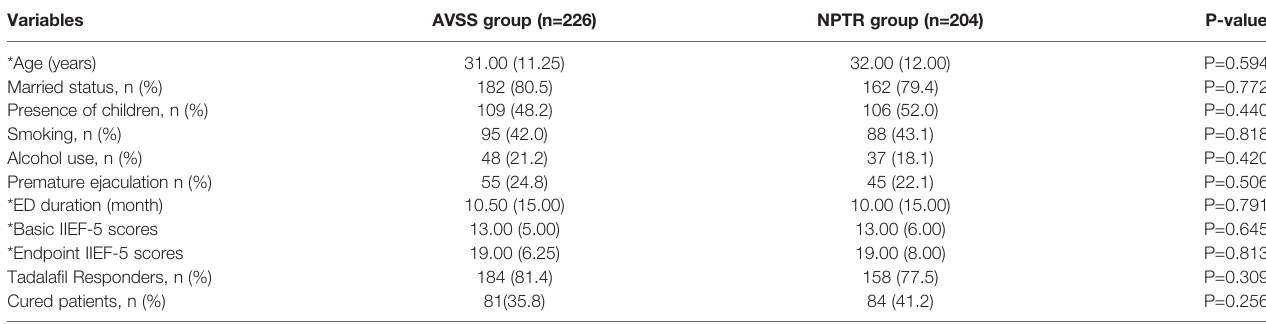
TABLE 1 | Subject demographic and baseline